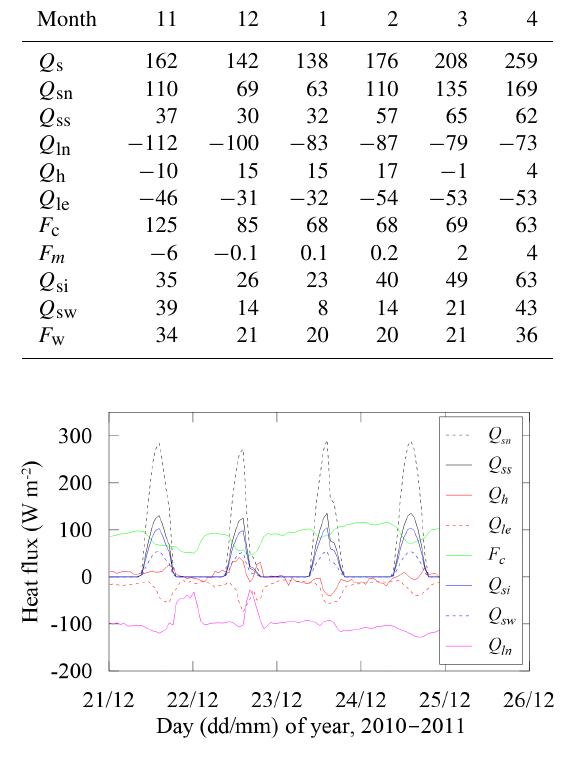
Figure 7. Diurnal patterns of various radiation/heat